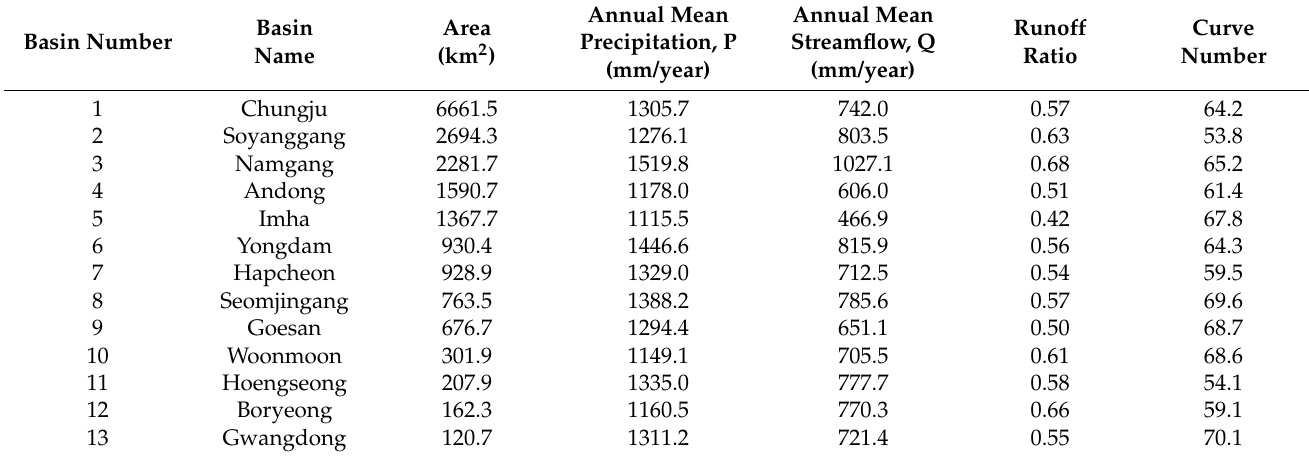
Table 1. Summary of hydro-meteorological information for the selected 13